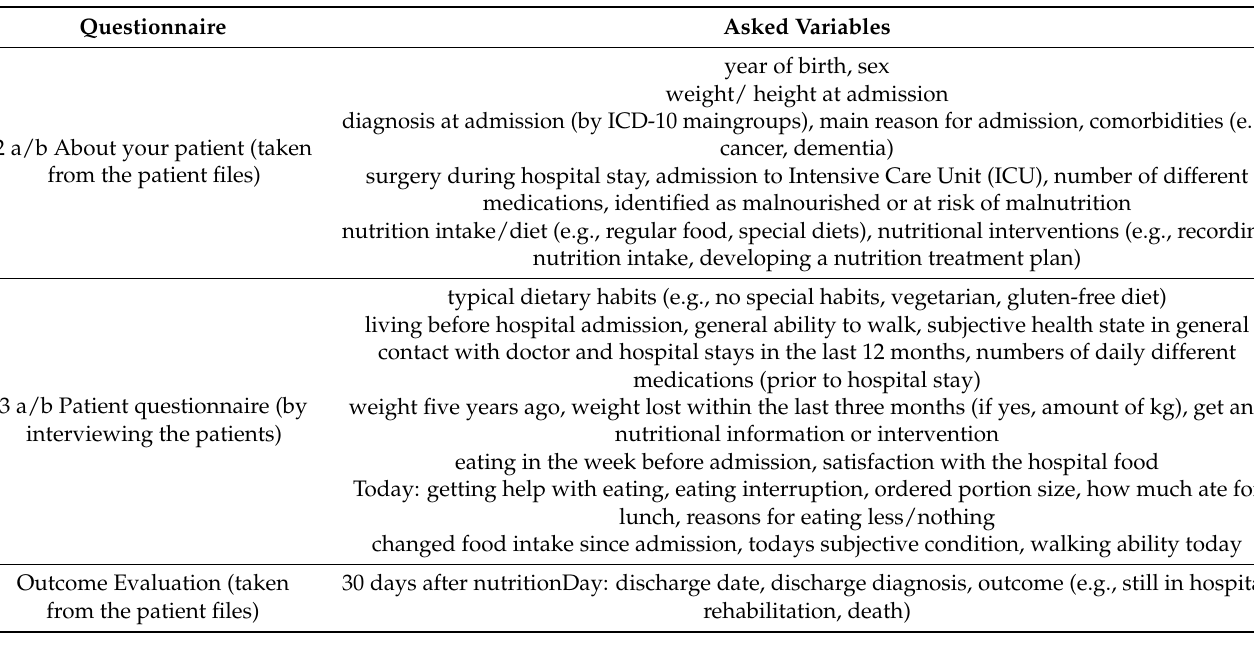
Table 1. Used nutritionDay